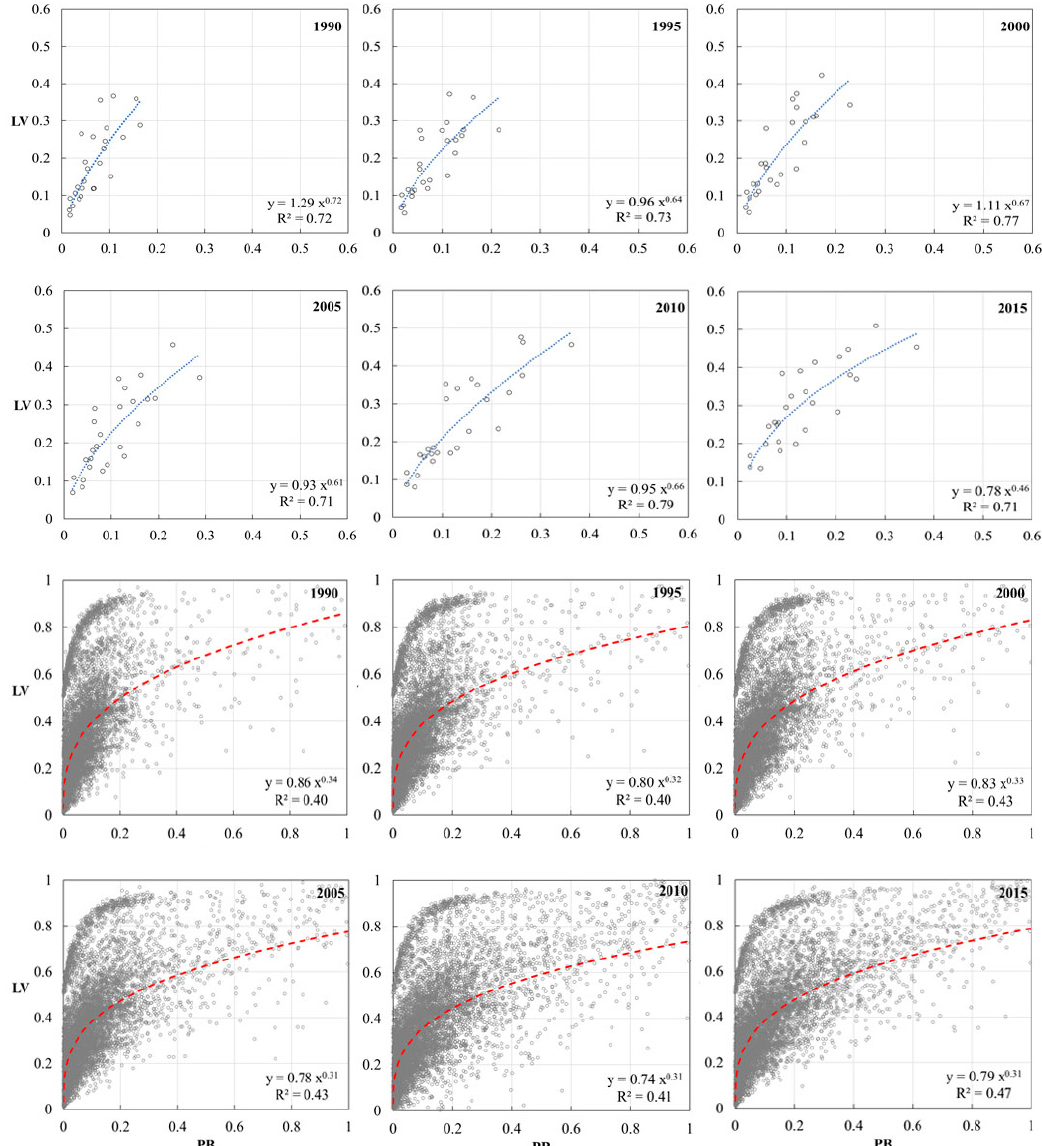
Figure 8. Scatter diagrams between LV and PB at the municipal scale and the 5 km-grid scale in the YRD from 1990 to 2015. When 0 < PB < 1, the functional relationship between LV and PB fitted a power-exponential growth curve well.